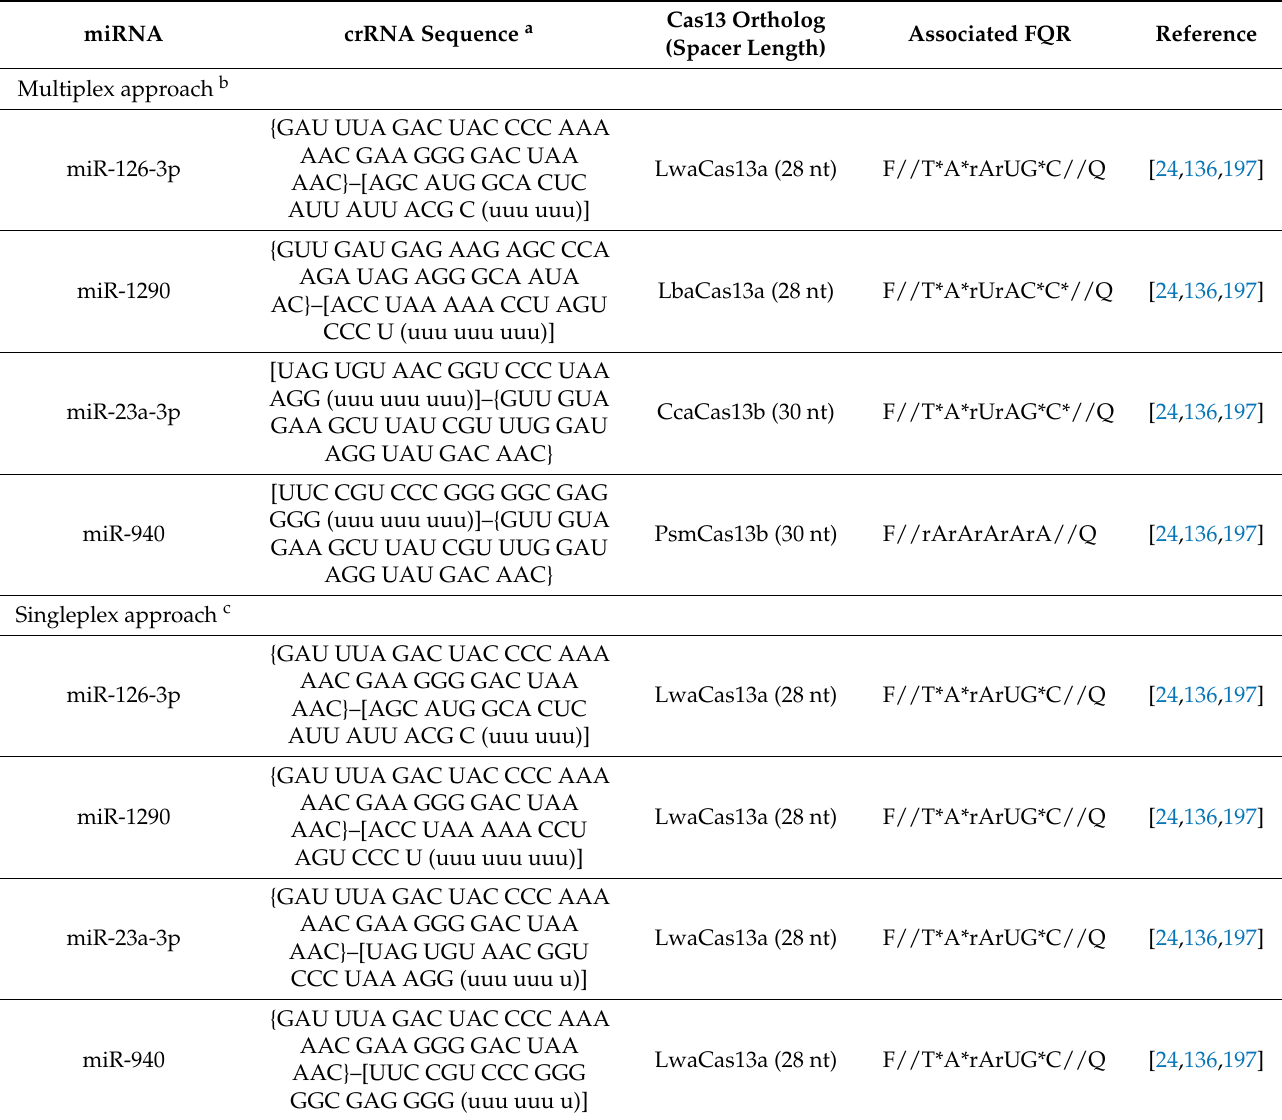
Table 5. CRC CEx-miRNAs panels for direct multiplex and singleplex approaches of CRISPR/Cas13-based diagnosis. miRNA crRNA Sequence a